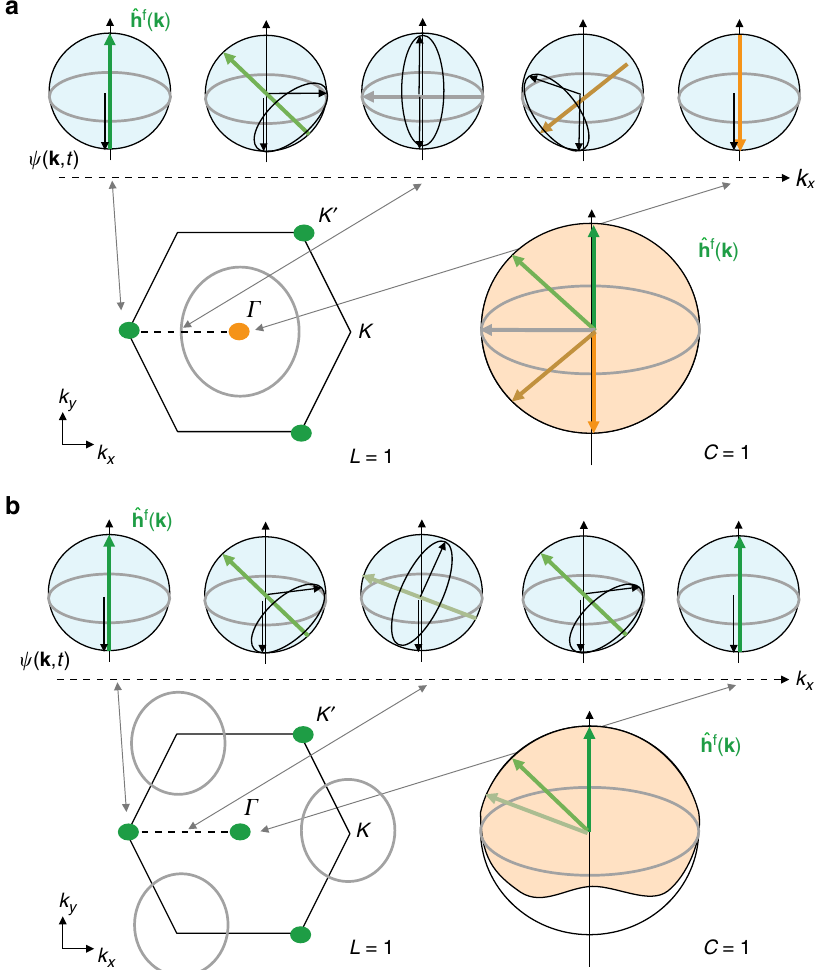
Fig. 7 Illustration of the mapping between linking number and Chern number. a The inverse images of the poles on the Bloch sphere form contours in the Brillouin zone. At the Dirac points, where the Hamiltonian points to one of the poles, there is no dynamics and the state will stay at the south pole and give rise to a static vortex (green and orange dots). Where the Hamiltonian lies on the equator, the time-evolved state will reach the north pole dynamically and will give rise to a dynamic vortex. These dynamic vortices move on a contour, which is the inverse image of the equator of the Bloch sphere (gray line). The Chern number of the Hamiltonian can be inferred from the linking number of the contour: if the dynamic vortex contour encloses one of the static vortices, then both static vortices correspond to opposite poles so that the Hamiltonian is topologically nontrivial. This can be seen by following the dynamics along a path connecting the two Dirac points (dashed line). In the depicted case, the Chern number is 1. b Same as ( a ), but for the case of a Chern number